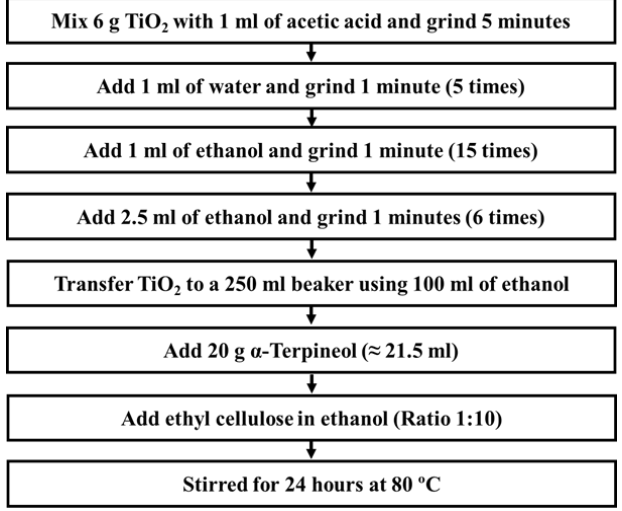
Figure 1. Preparation of TiO 2 paste.